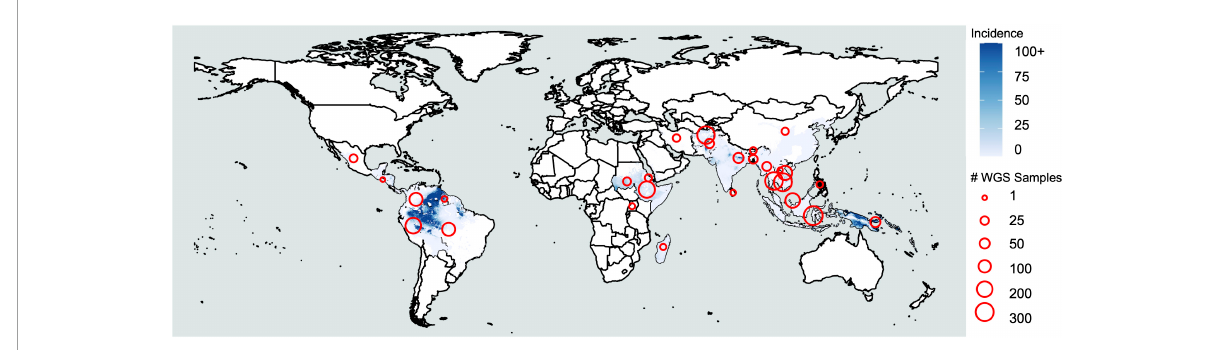
FIGURE1 Plasmodium vivax incidence and whole-genome sequencing. Coloration represents incidence per 1000 based on raster data from the Malaria Atlas Project (https://malariaatlas.org/malaria-burden/) in 2017, the most recent year for which data is available. Red circles represent whole-genome sequencing samples collected by country based on Supplementary Table 1